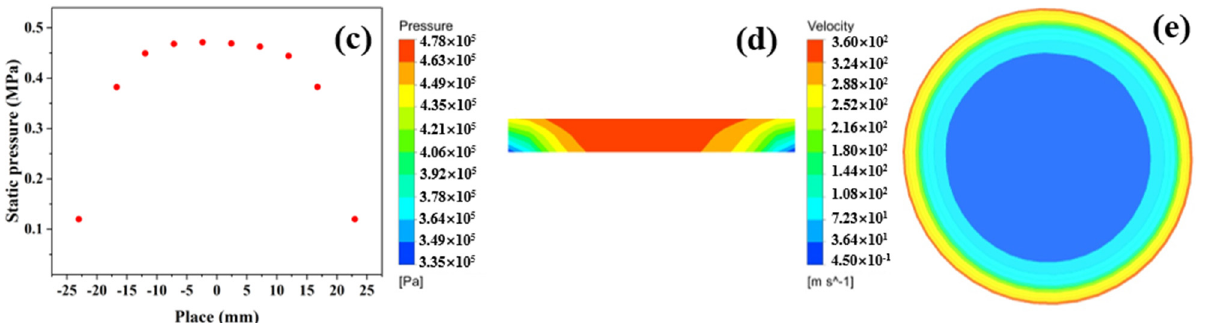
Figure 6. The residual convergence curve and flowing gas state under the conditions of Ps = 0.5 MPa, h = 10 μ m, and φ = 2.78 × 10 − 13 m 2 : ( a ) residual convergence curve; ( b ) pressure contours of load surface; ( c ) two-dimensional distribution; ( d ) pressure distribution on profile of porous media; ( e ) gas-flow velocity of bearing clearance.